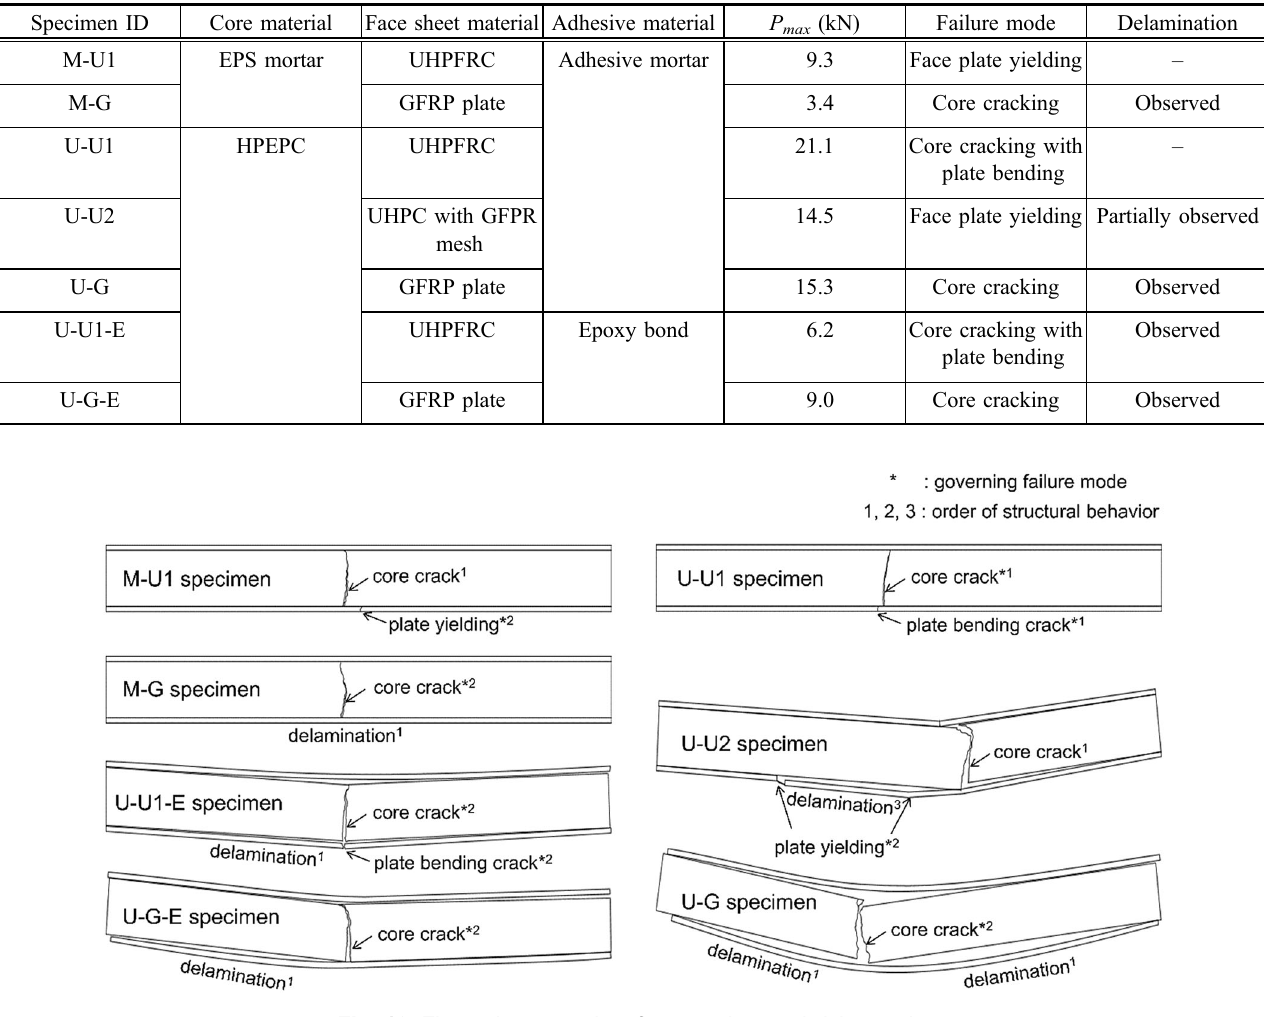
Table 8 Four-point bending test results for composite sandwich